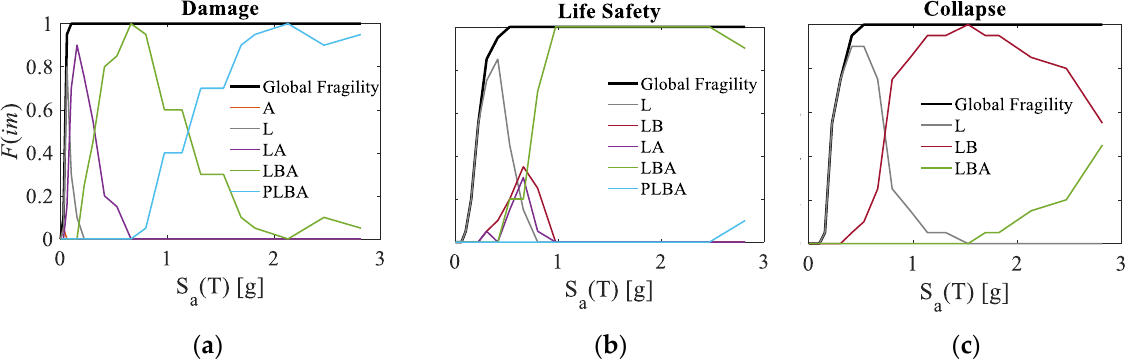
Figure 12. Multiple damage fragility curves at ( a ) damage; ( b ) life safety; and ( c ) collapse performance levels; envelope global fragility curves depicted by black solid lines.